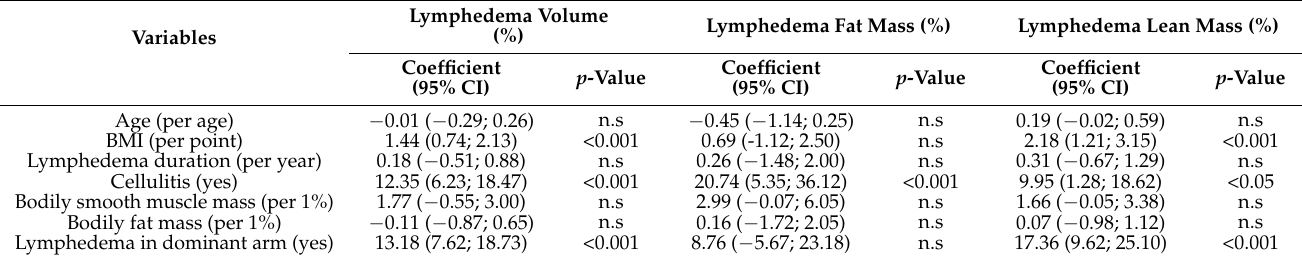
Table 2 legend: This table shows the multivariate linear regression models for lymphedema volume, fat mass, and lean mass predictors. n.s = not